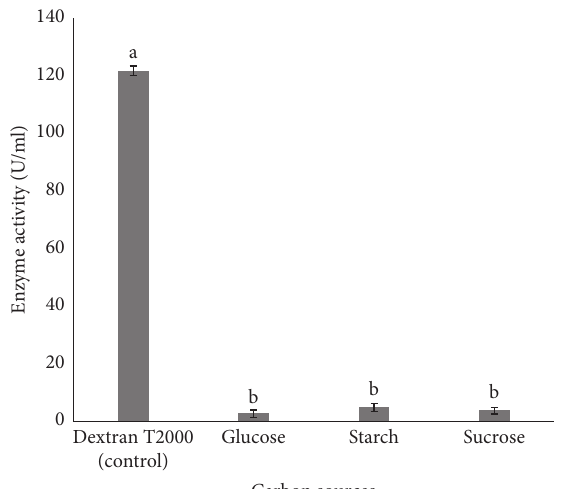
Figure 3: Effect of carbon sources on dextranase production from Talaromyces sp. at the second day of fermentation. Symbols (mean ± SE, n � 6) having similar letters are not significantly different from each other (Bonferroni, P < 0 .